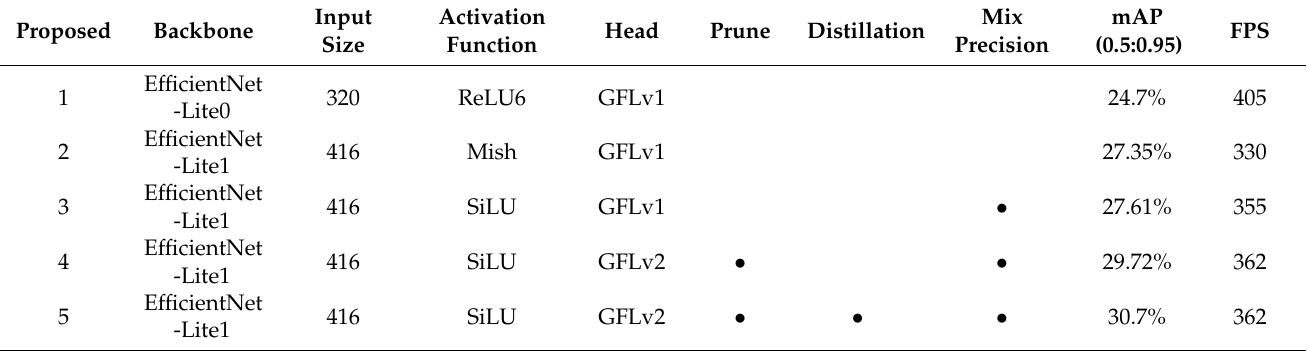
Table 2. Performance comparison of different EfficientNet